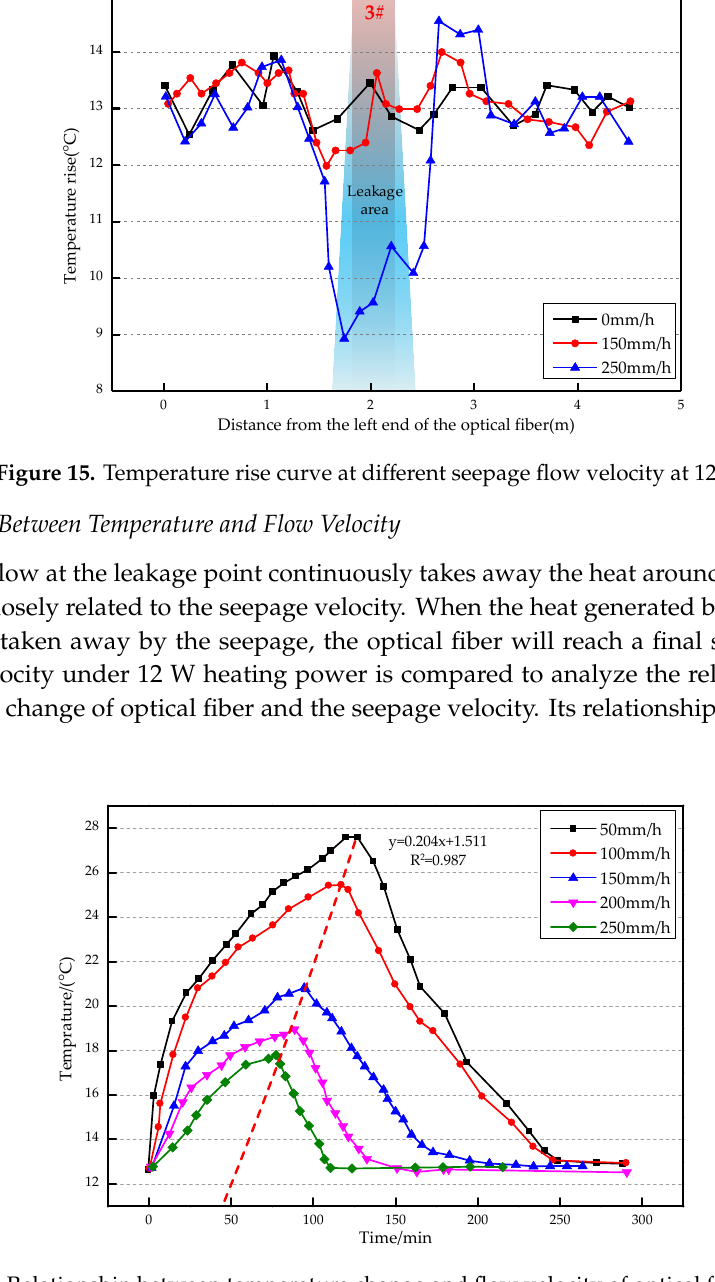
Figure 16. Relationship between temperature change and flow velocity of optical fibers at 12 W.